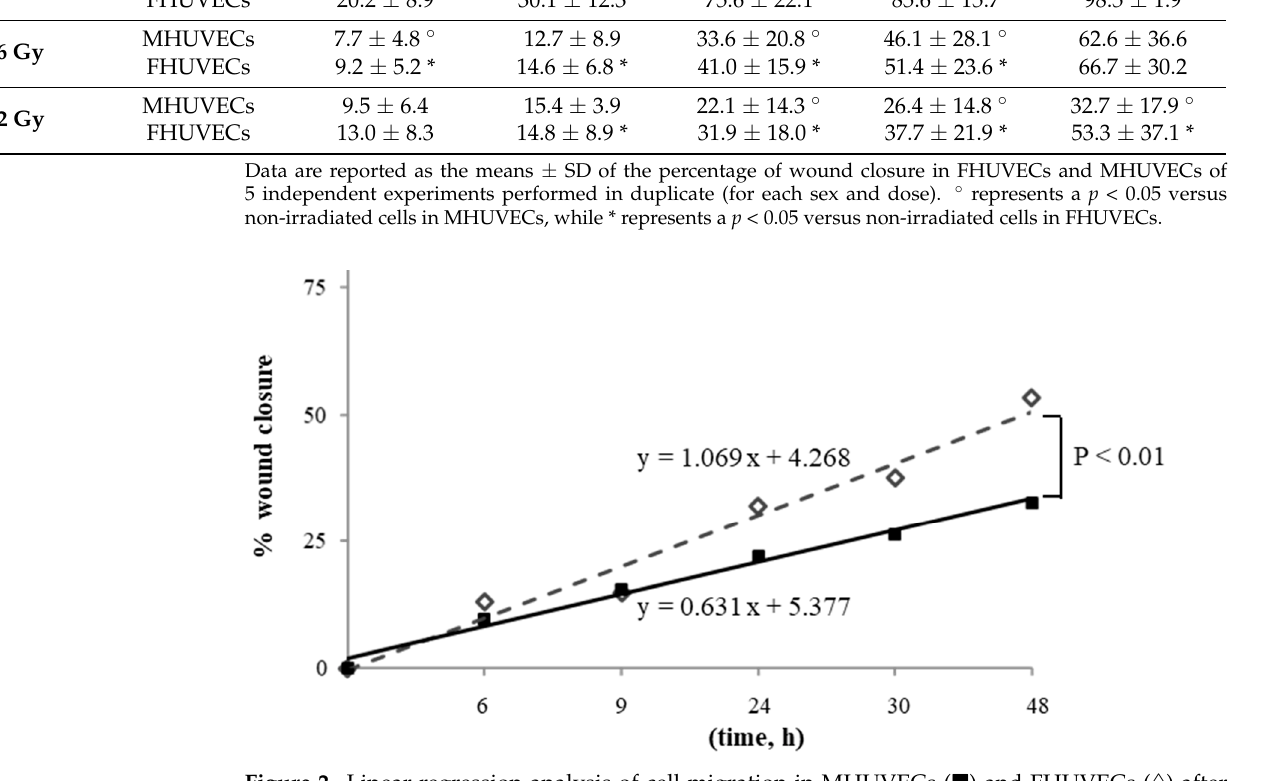
Figure 2. Linear regression analysis of cell migration in MHUVECs ( ■ ) and FHUVECs ( ◊ ) after exposure to 3.2 Gy of X ‐ rays.